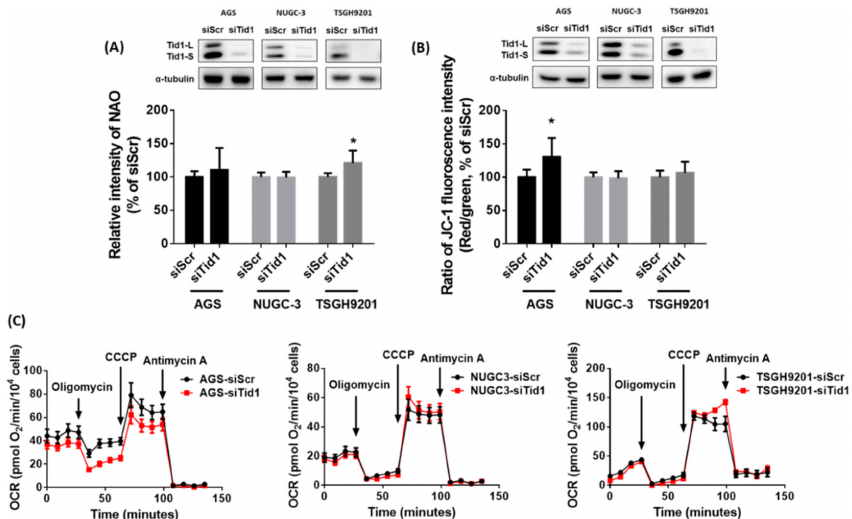
Figure 5. E ff ects of Tid1 knockdown on mitochondrial mass, mitochondrial membrane potential, and mitochondrial oxygen consumption rate (OCR) of gastric cancer cells. ( A ) The e ff ect of Tid1 knockdown on mitochondrial mass was evaluated by flow cytometry with nonyl acridine orange (NAO) staining. ( B ) The e ff ect of Tid1 knockdown on mitochondrial membrane potential was evaluated by flow cytometry with JC-1 staining. ( C ) The e ff ect of Tid1 knockdown on mitochondrial OCR was determined by Seahorse XF e Analyzer. After knockdown of Tid1 by siRNA, the gastric cancer cells were reseeded and mitochondrial OCR was evaluated until cells were attached (overnight). The e ffi ciency of Tid1 knockdown was confirmed by Western blot. Data are shown as the mean ± SD of two or three independent experiments. *, p < 0.05, compared with the siRNA for scramble (siScr) control